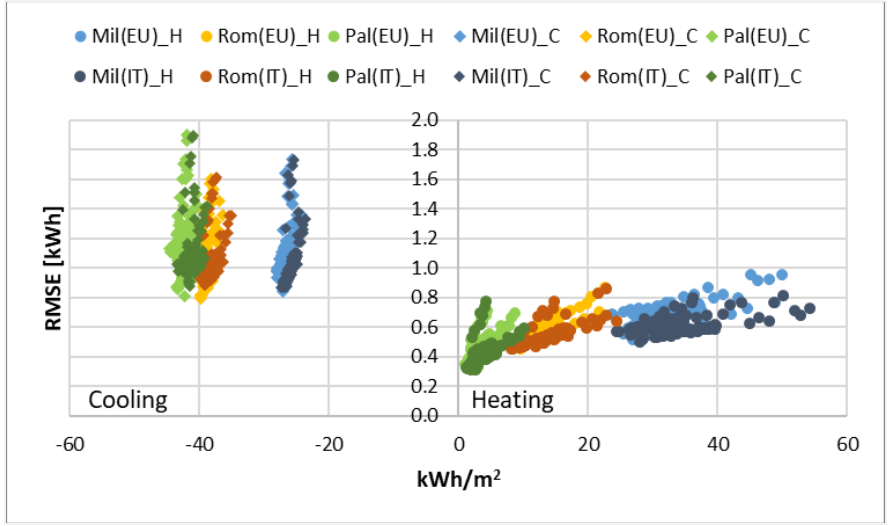
Figure 6. RMSE for heating and cooling needs, for all climates of the case study and for both methods (EU: Annex B, IT: Annex A): Case study with g gl,n = 0.77.